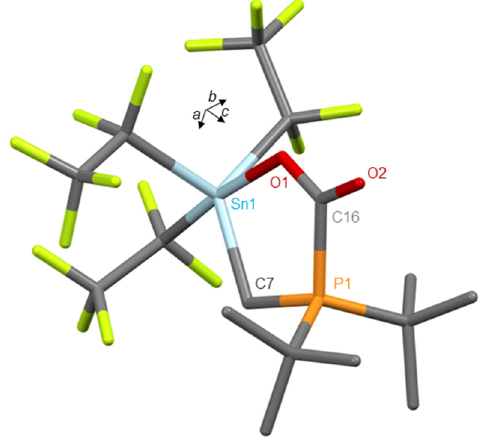
Figure 18. Molecular structure of 15 , adapted from [70] (MERCURY view). Hydrogen atoms are omitted for clarity (Sn light blue, O red, P orange, C grey, F green). Table 6. Selection of spectroscopic data (NMR and IR) assigned to phosphinoformato of tin complexes. Compounds